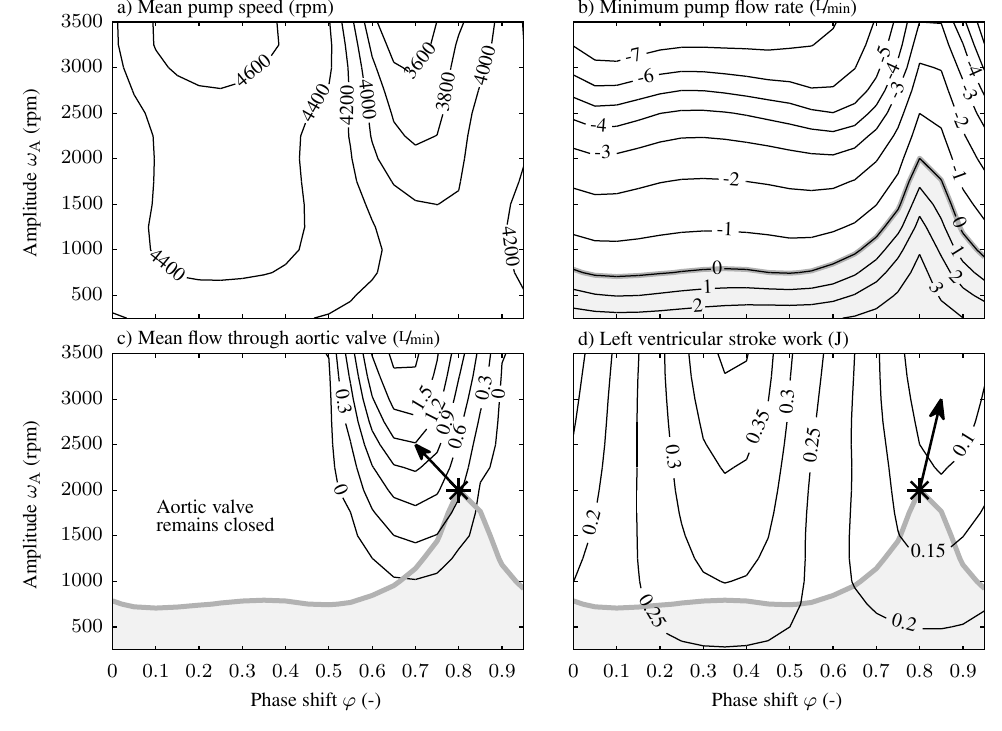
Figure 5. Results of the parametric study on the sinusoidal speed profile. All plots show contour lines of a specific measure, as indicated in the corresponding heading. Panel ( a ) shows the mean pump speed, ω in rpm . Panel ( b ) shows the minimum value of the flow rate c through the pump in L / min . The gray area indicates the admissible region. Backflow from the aorta to the left ventricle occurs in the complementary region. Panel ( c ) shows the mean flow rate through the aortic valve in L / min . There is a large region where the aortic valve remains closed. Panel ( d ) shows the left ventricular stroke work. The asterisks and arrows in panels ( c ) and ( d ) denote the optimal point according to objective function Equation (9a) and the corresponding directions of the steepest descent. The admissible region shown in panel ( b ) is repeated in panels ( c ) and ( d